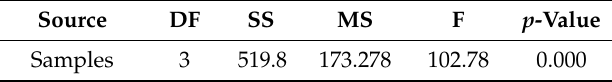
Table 1. ANOVA: Amplitude of the peak (MPa) and %NbB 2 .